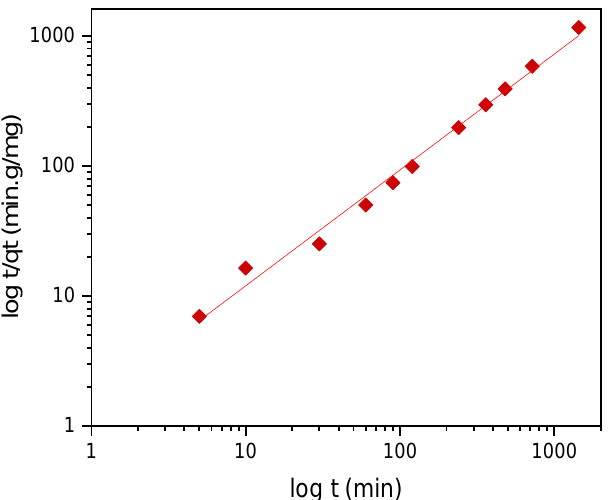
Figure 12. The linear pseudo-second-order kinetic model. Red squares—experimental t/q t data. Table 6. Parameters of the PFO and PSO kinetic models. Table 5. Nonlinear and linear forms of the PFO and pseudo-second-order (PSO) kinetic models. PFO Model PSO Equation PFO Model PSO Model Form Nonlinear